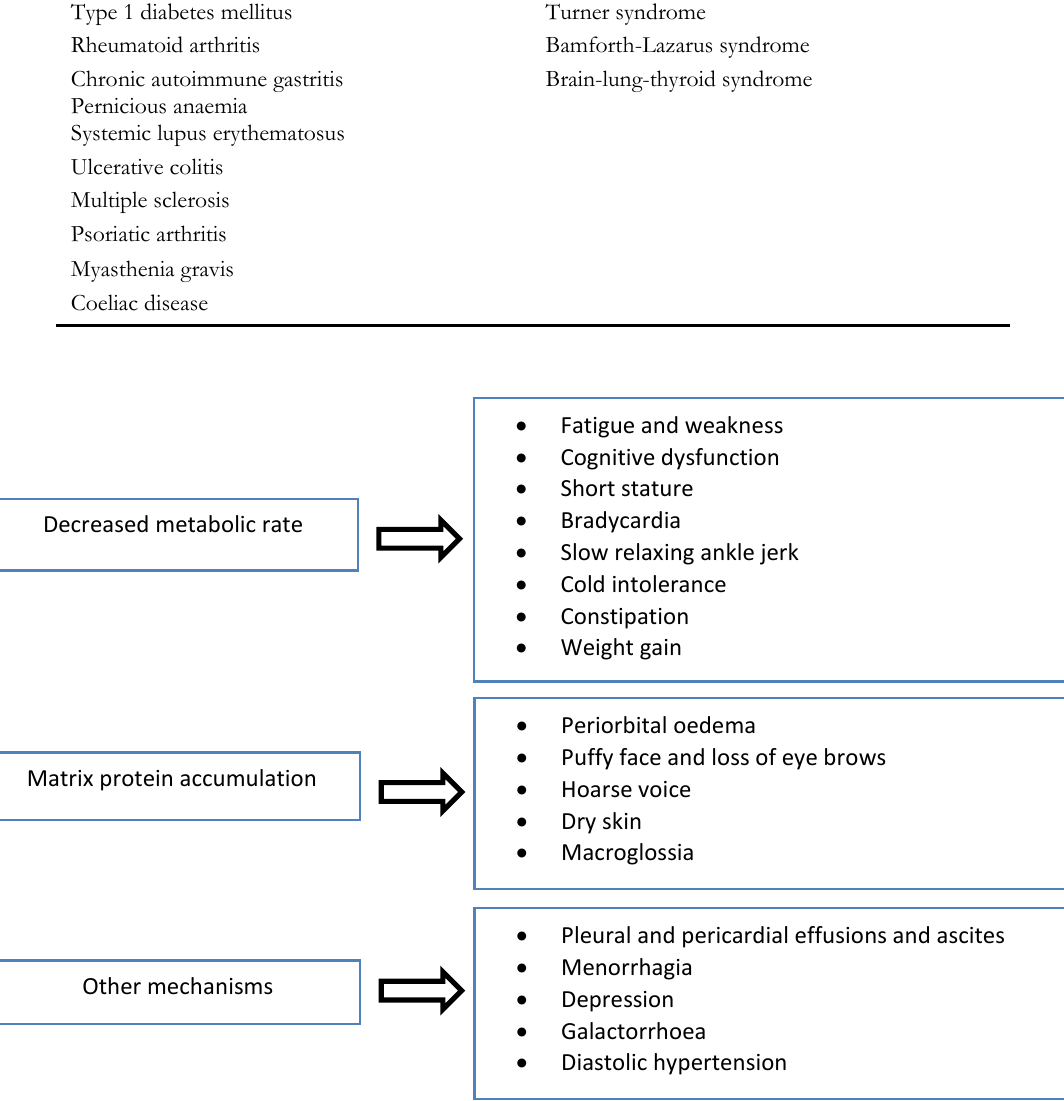
Figure 2.3. Symptoms and signs of hypothyroidism (19)